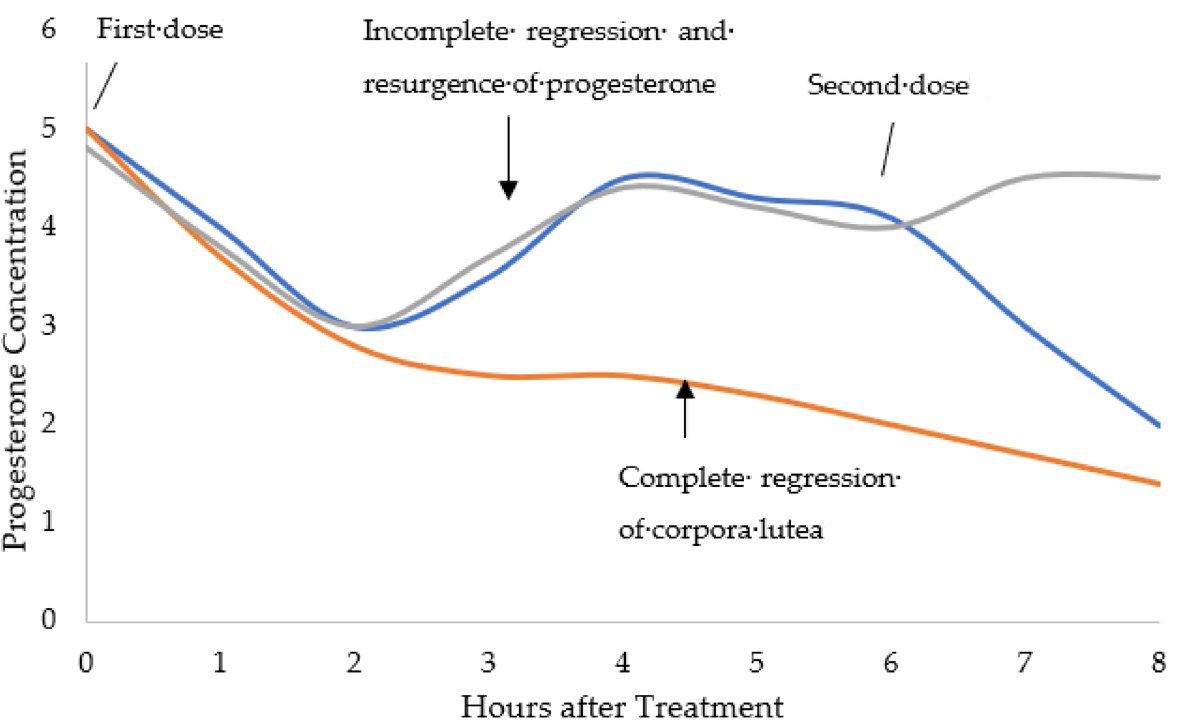
Figure 1. Graphical representation of how progesterone concentrations fluctuate when sows are given a luteolytic agent (i.e., cloprostenol). The first dose can trigger complete regression for successful induction (orange line) or incomplete regression causing an unsuccessful induction (grey